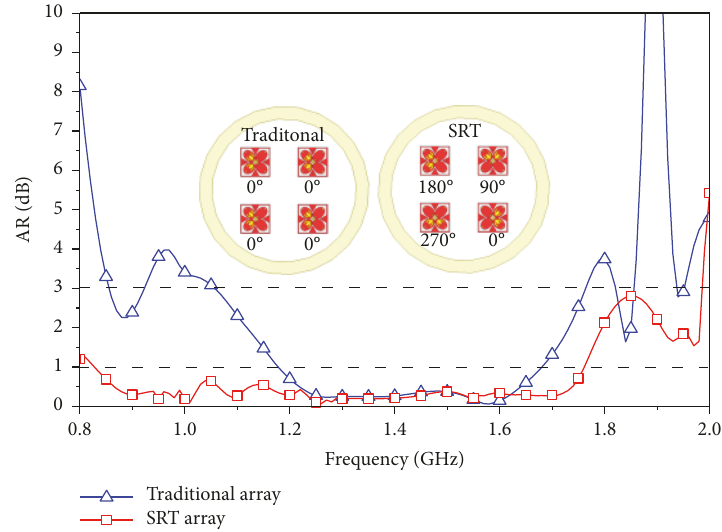
Figure 11: Simulated ARs at broadside direction of the traditional and the SRT array.